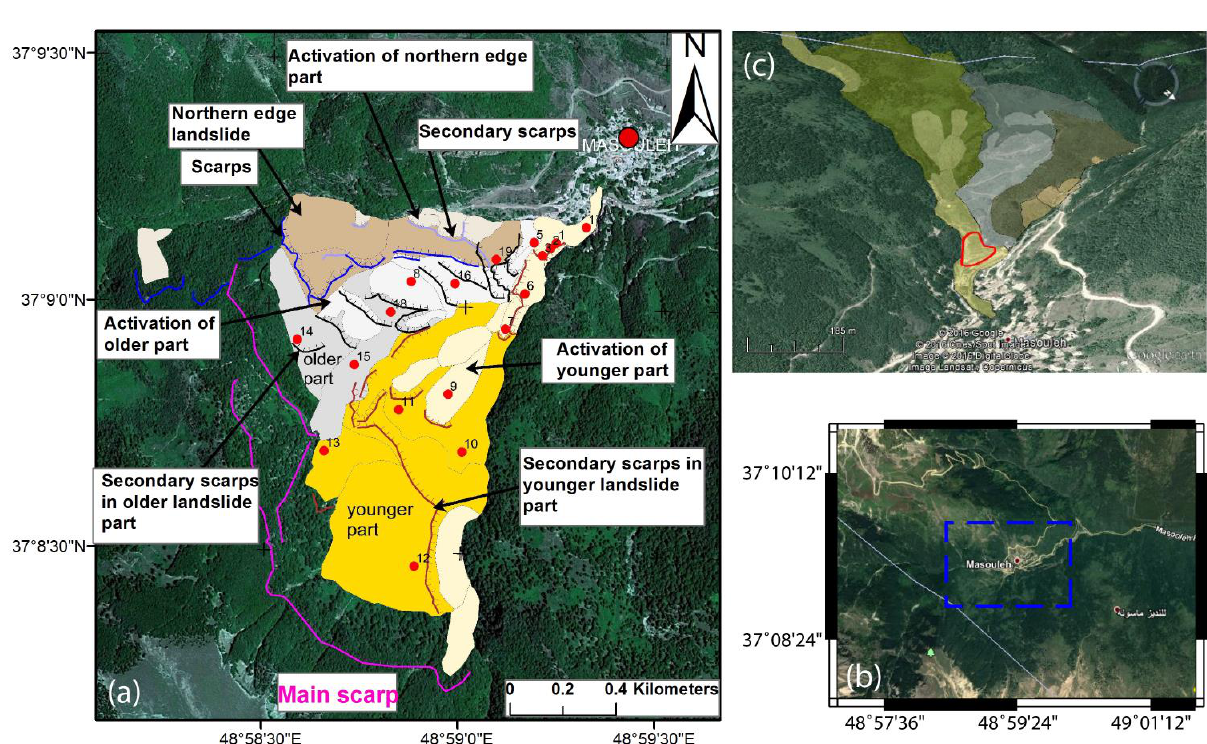
Figure 1. (a) Masouleh landslide; geological scarps and moving body are overlayed on the SPOT image acquired on 8 February 2015. Three main regimes of the landslide are depicted with yellow, gray and brown polygons showing the younger part, older part and northern edge of the landslide respectively. The red circle shows Masouleh city. (b) Google Earth image of the Masouleh city with the blue dashed rectangle showing cropped area of SAR image that is used in the processing. (c) Three dimensional view of the moving slope. The red polygon illustrates the most active slope on the lower part of the younger